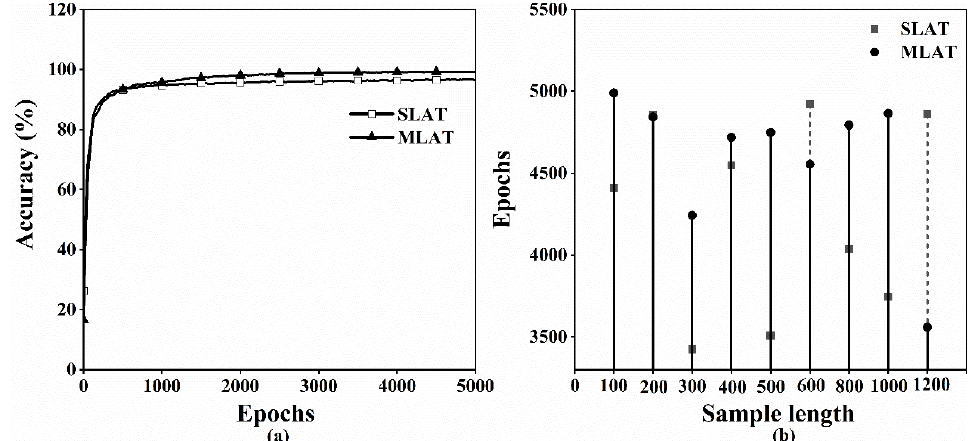
Figure 9. ( a ) Accuracy comparison between SLAT and MLAT ; ( b ) Comparison of rounds of SLAT and MLAT to achieve optimal results.